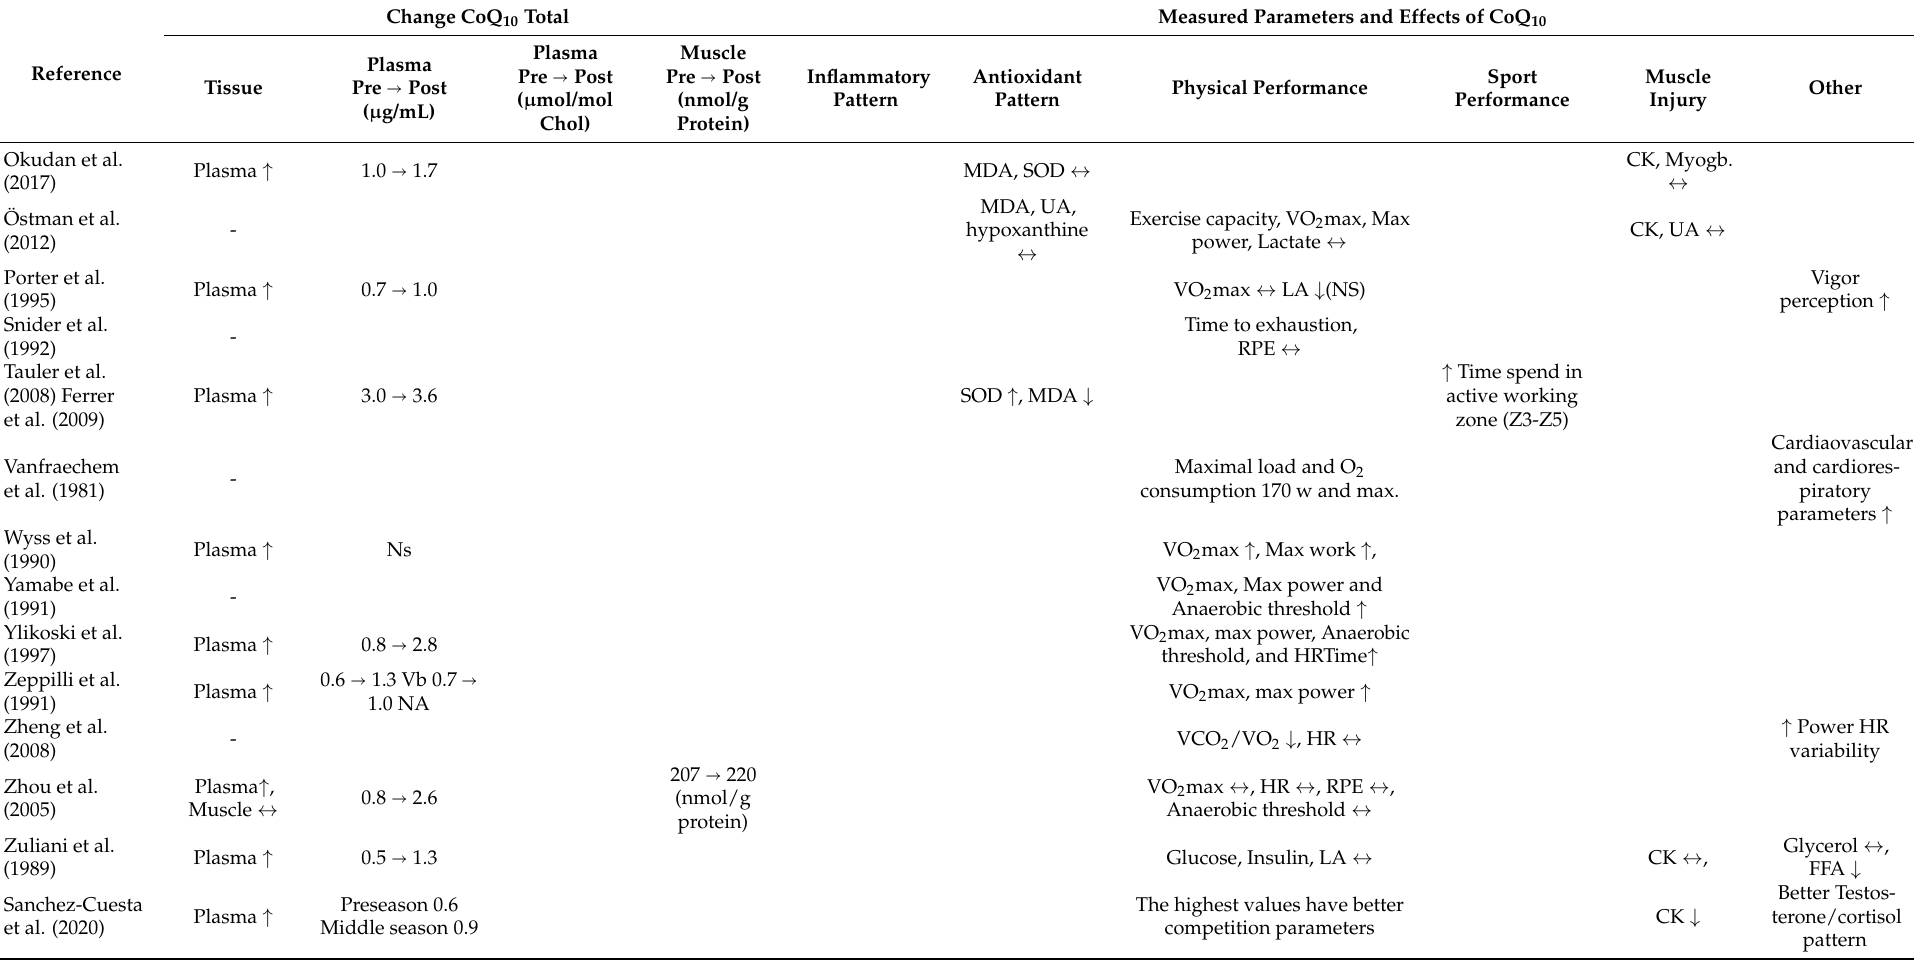
Table 9. Studies without the inclusion